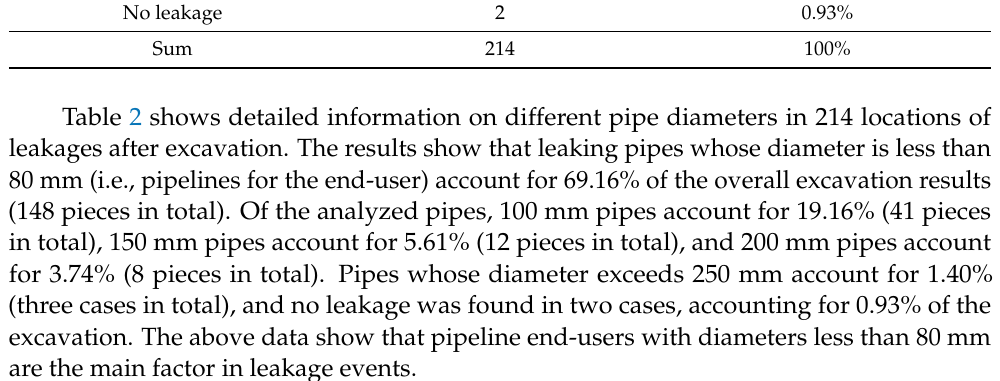
Table 2. Localized AI water leakage diagnostic instrument excavation verification: leaking pipe di- ameter statistics.